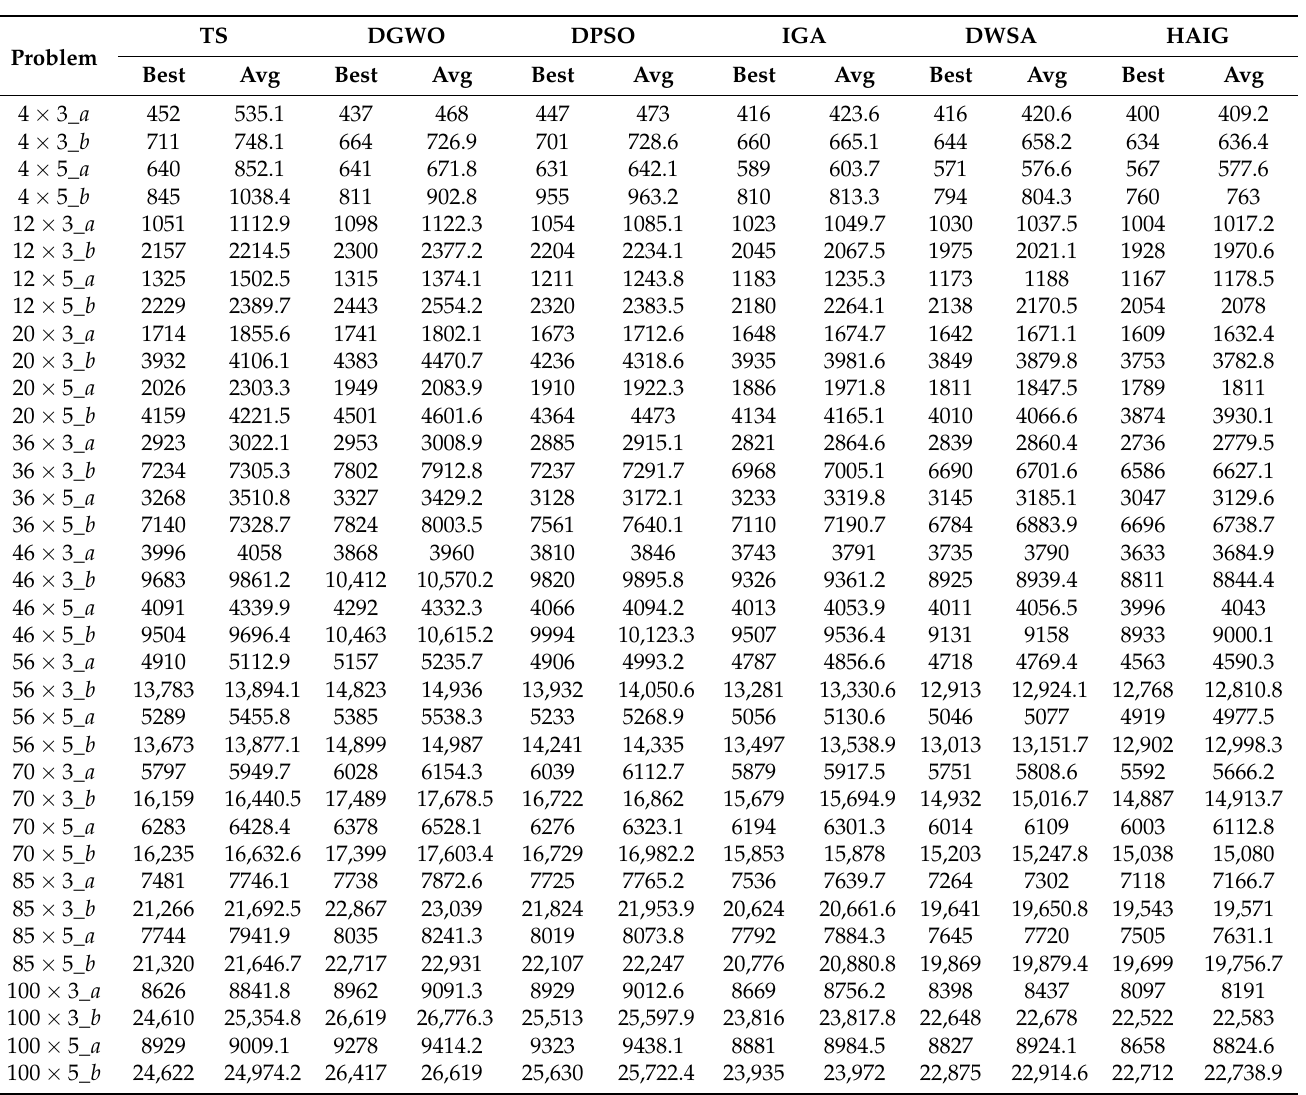
Table 4. Comparisons of the